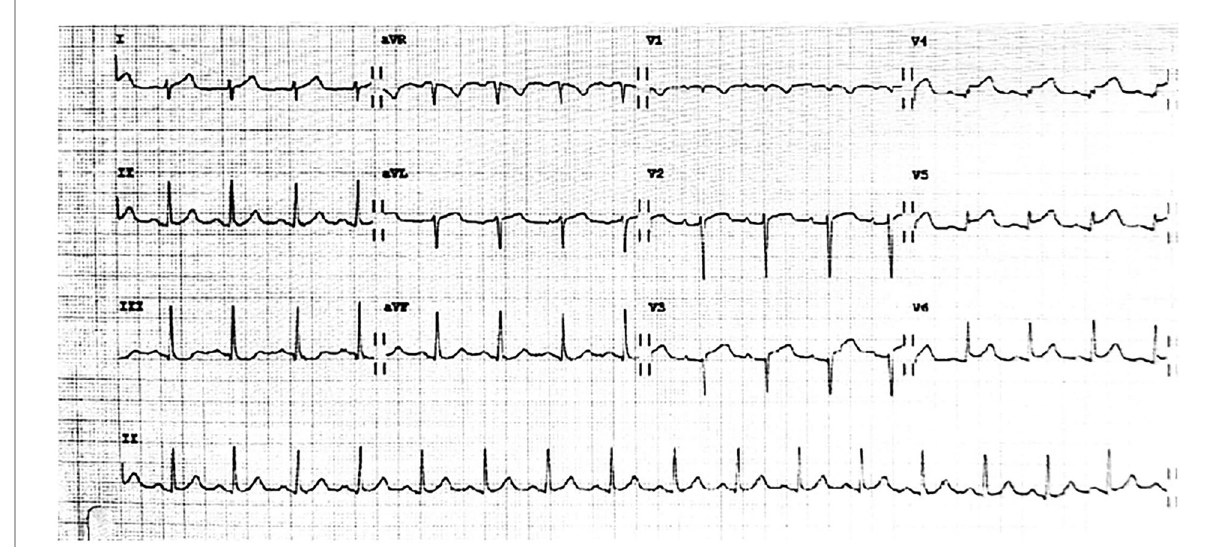
FIGURE 1 Twelve-lead electrocardiogram showed ST-segment elevation in leads I, aVL, and